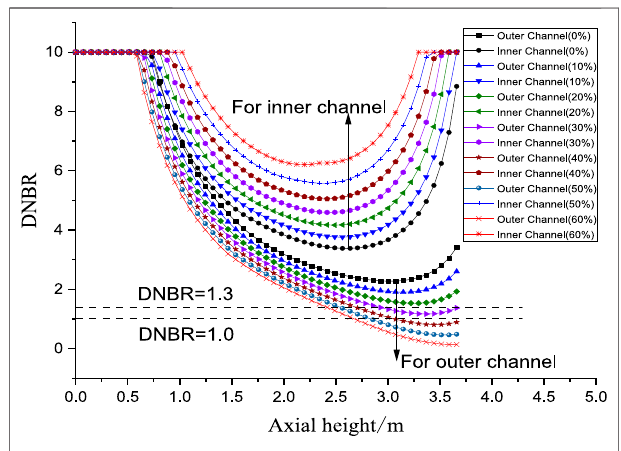
FIGURE 16 | Inner and outer channel DNBR variation at different swelling ratios.